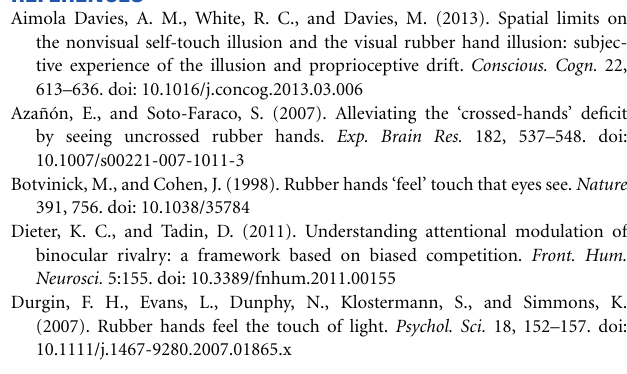
FIGURE 9 | Results of the directivity distribution of seven (A–G) “illusion-sensitive” participants for three types of body midline alignments in Experiment II. Each body midline alignment experiment contains five sessions. The individual data from each session are plotted as a small blank circle, while a large colored circle represents the average attractivity for each body midline alignment. The directivity values in the Crossed × ROS condition of Experiment I (including two sessions every